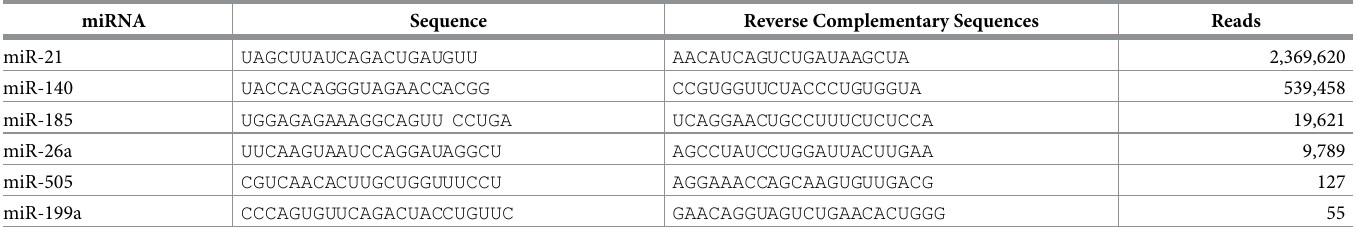
Table 1. Candidate miRNAs and reverse-complementary sequences. miRNA Sequence Reverse Complementary Sequences